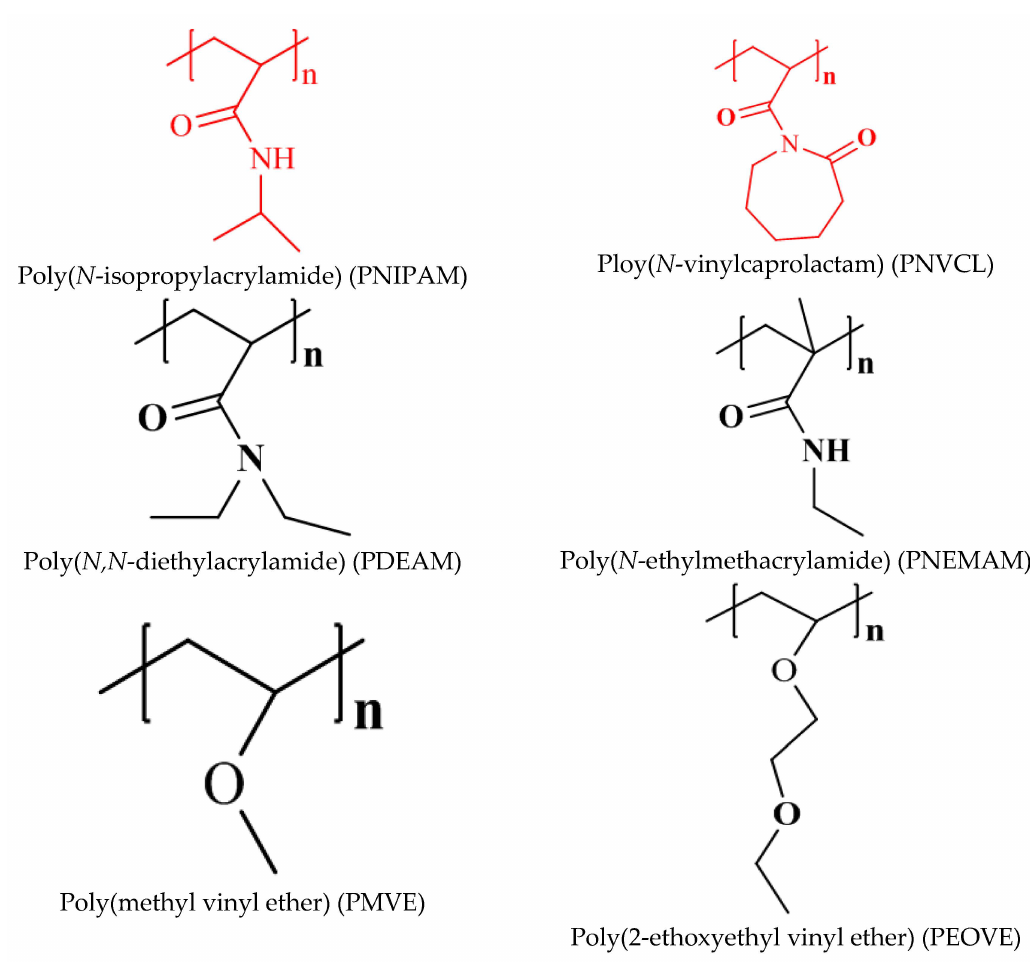
Figure 1. Chemical structures of the thermoresponsive